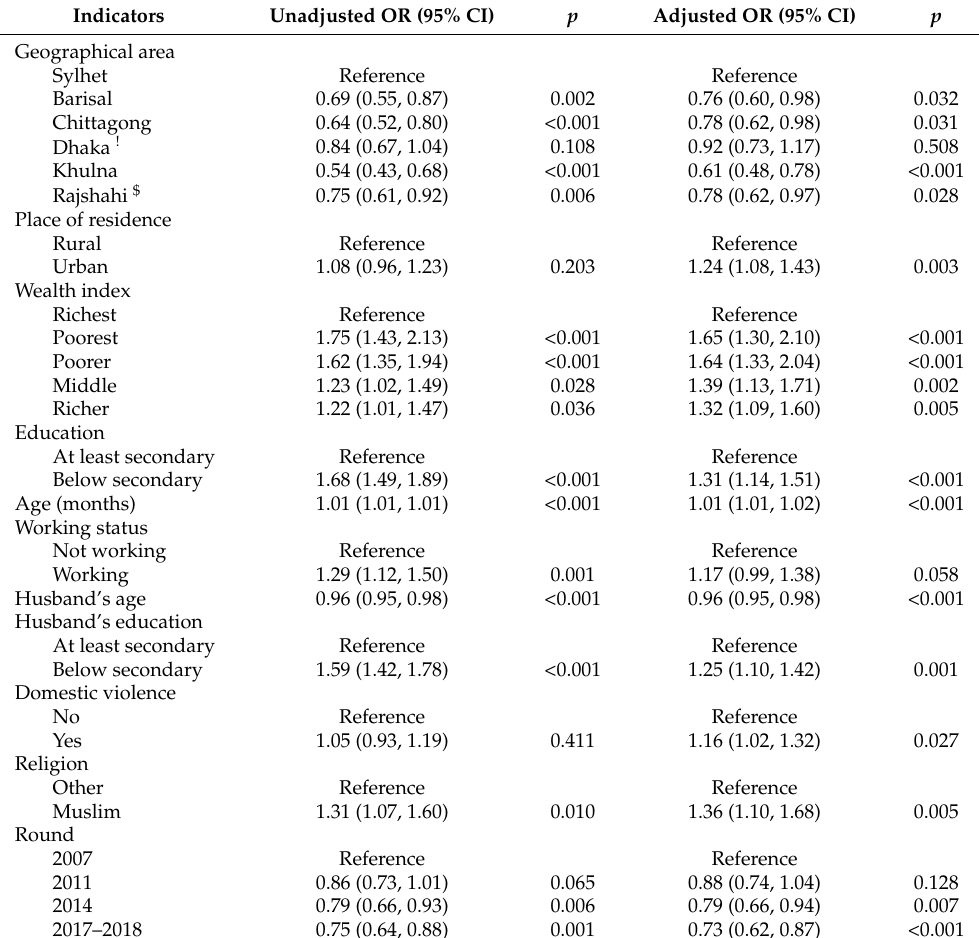
Figure 2. Stunting prevalence in children whose mothers were adolescents was stratified by geo- graphical region and round of the BDHS survey. Table 2. Factors associated with the stunting status of ever-married